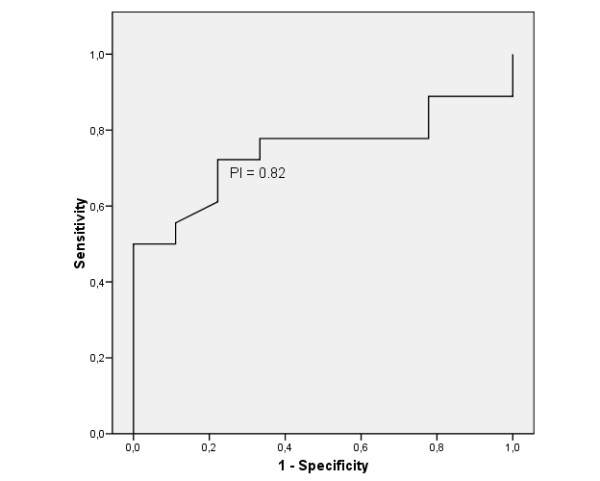
ROC curve for pulsatility index. The best cut-off was 0.82.